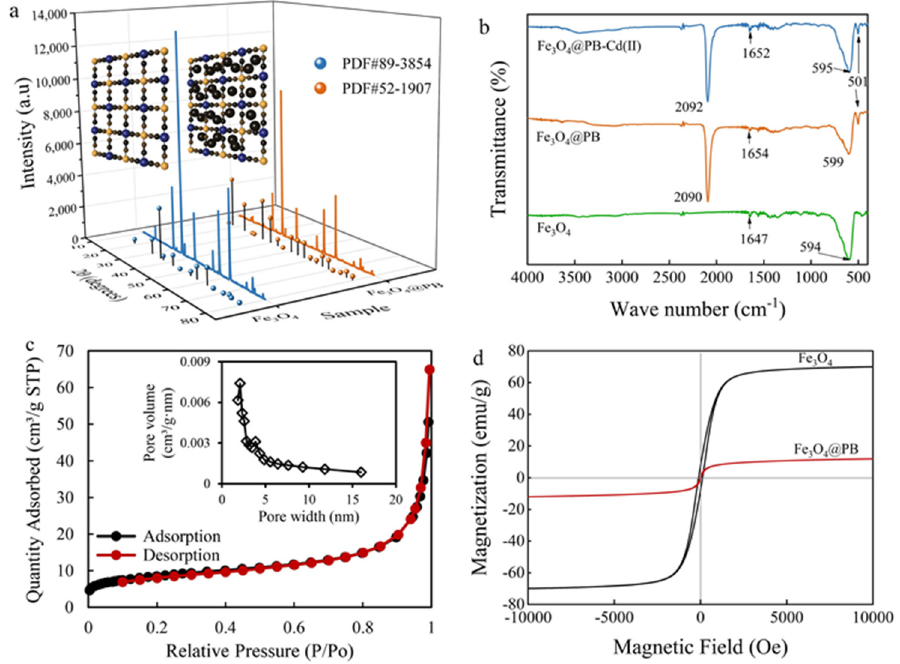
Figure 2. ( a ) XRD patterns; ( b ) FTIR spectra; ( c ) N 2 adsorption/desorption isotherms of the compo- sites (inset figure is the pore size distribution); ( d ) magnetic hysteresis loops of Fe 3 O 4 and Fe 3 O 4